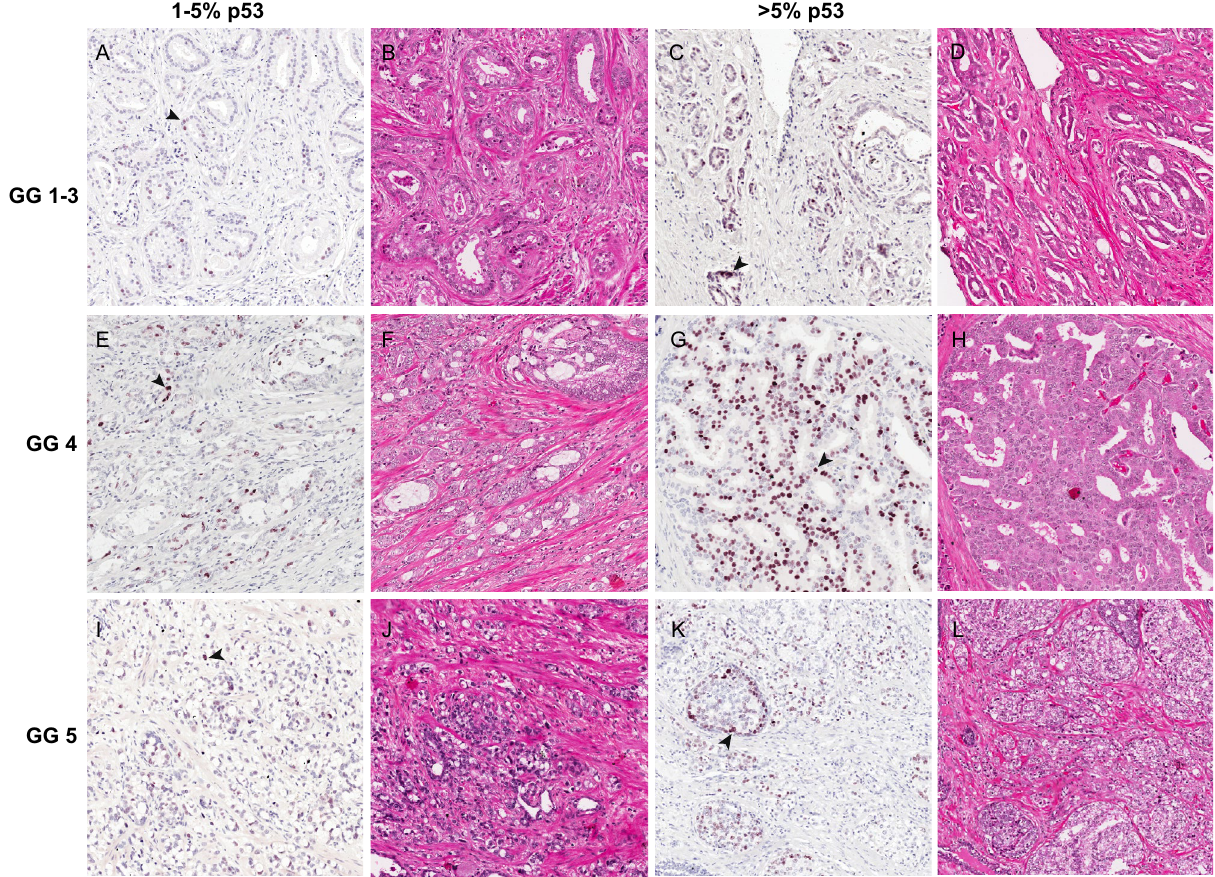
Figure 1. Representative p53 expression in index tumors clustered by tumor grade. p53 staining, detected at variable degrees of intensity between 1 and 5% ( A , E and F ) and > 5% ( C , G , and K ) and their corresponding sections stained with ( H & E ) are shown for each of the GG clusters: GG 1–3 ( A to D ), GG 4 ( E to H ), and GG 5 ( I to L ). Images were captured at 10X magnification. Arrowhead indicates individual cells stained by the p53